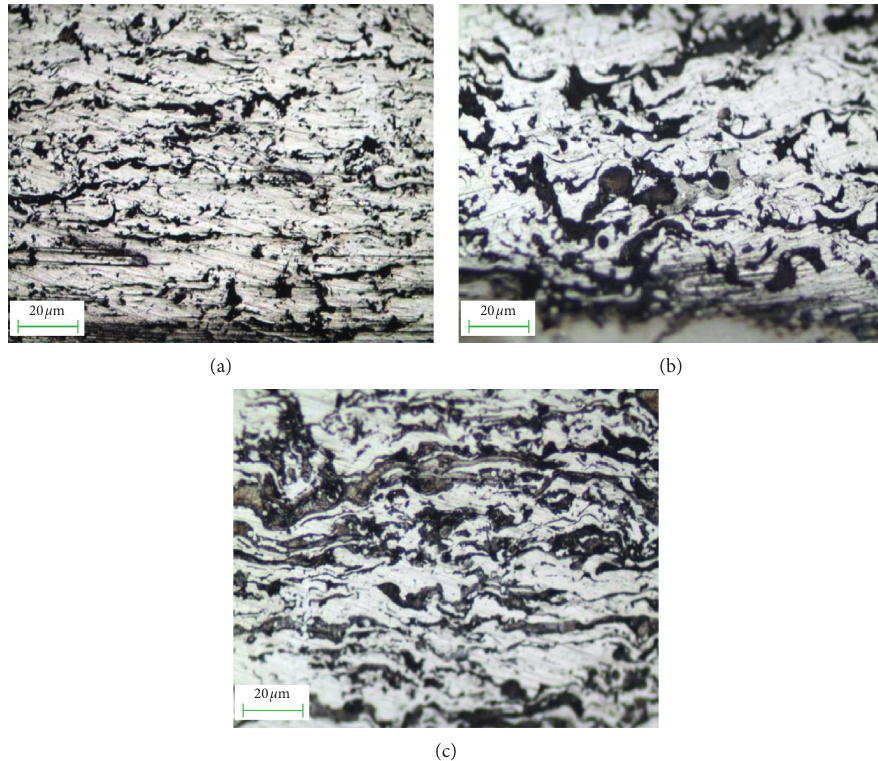
Figure 4: Metallographic photograph of the coating section: (a) 20% Al-80% Zn, (b) 30% Al-70% Zn, and (c) 40% Al-60% Zn.